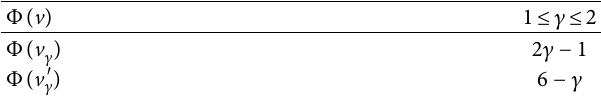
Table 36: Vertex labeling of Φ ( v ).